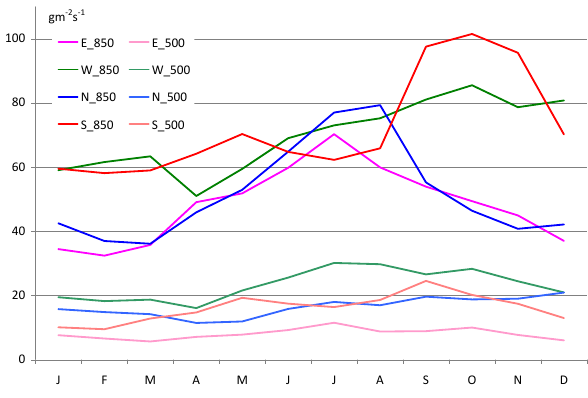
Fig. 5. Annual cycle of intense moisture fluxes within the study region. For each month, the means of 10 most intense moisture fluxes from each direction are depicted. The intensity of moisture flux is averaged over six studied